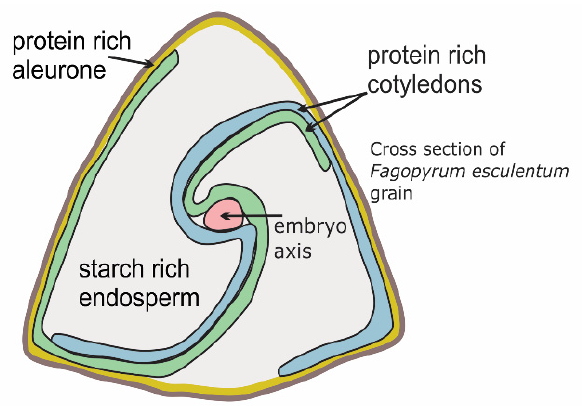
Figure 1. Cross-section of a common buckwheat grain.